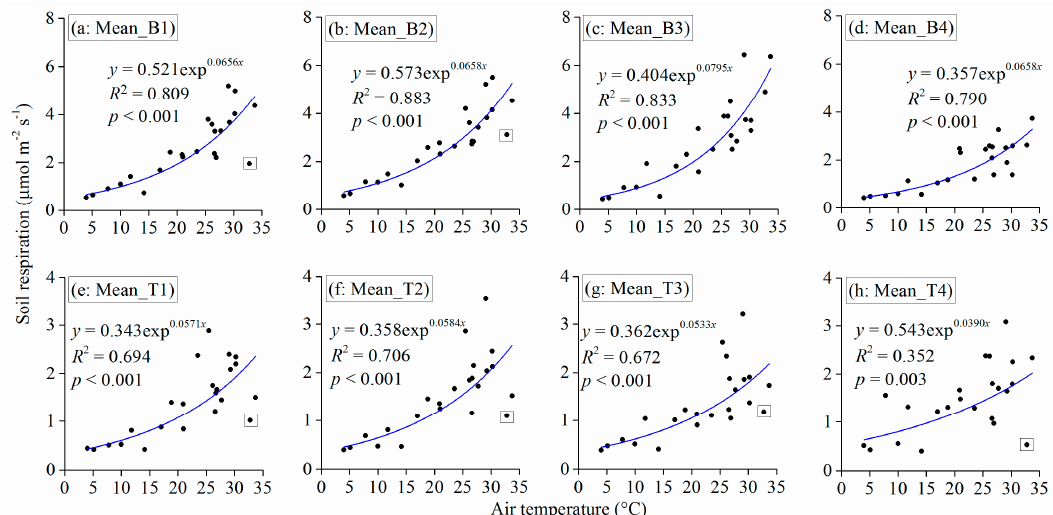
Figure 9. Correlations between observed air temperature and soil respiration at bamboo (panels ( a – d ): sites B1–B4) and tea (panels ( e – h ): sites T1–T4) plots. Both air temperature and soil respiration